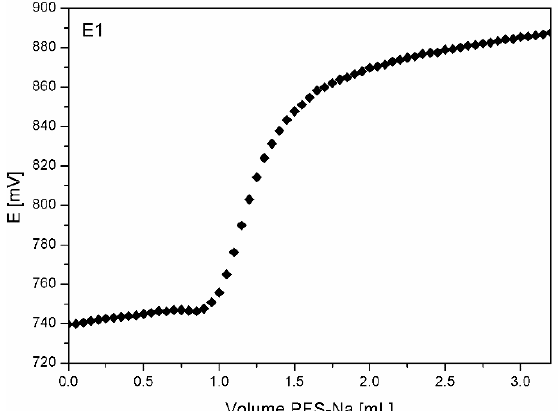
Figure 7. Polyelectrolyte titration curve on the example of sample E1 after 24 h.